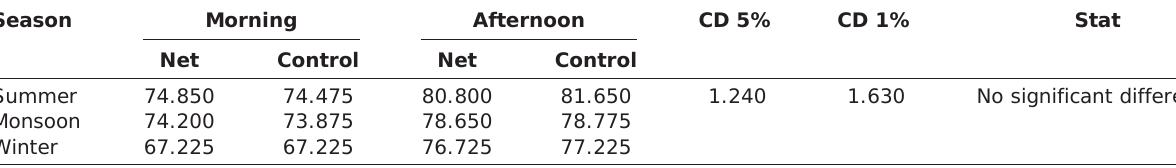
Table-3: Comparison of THI estimated in the net shed and control shed.